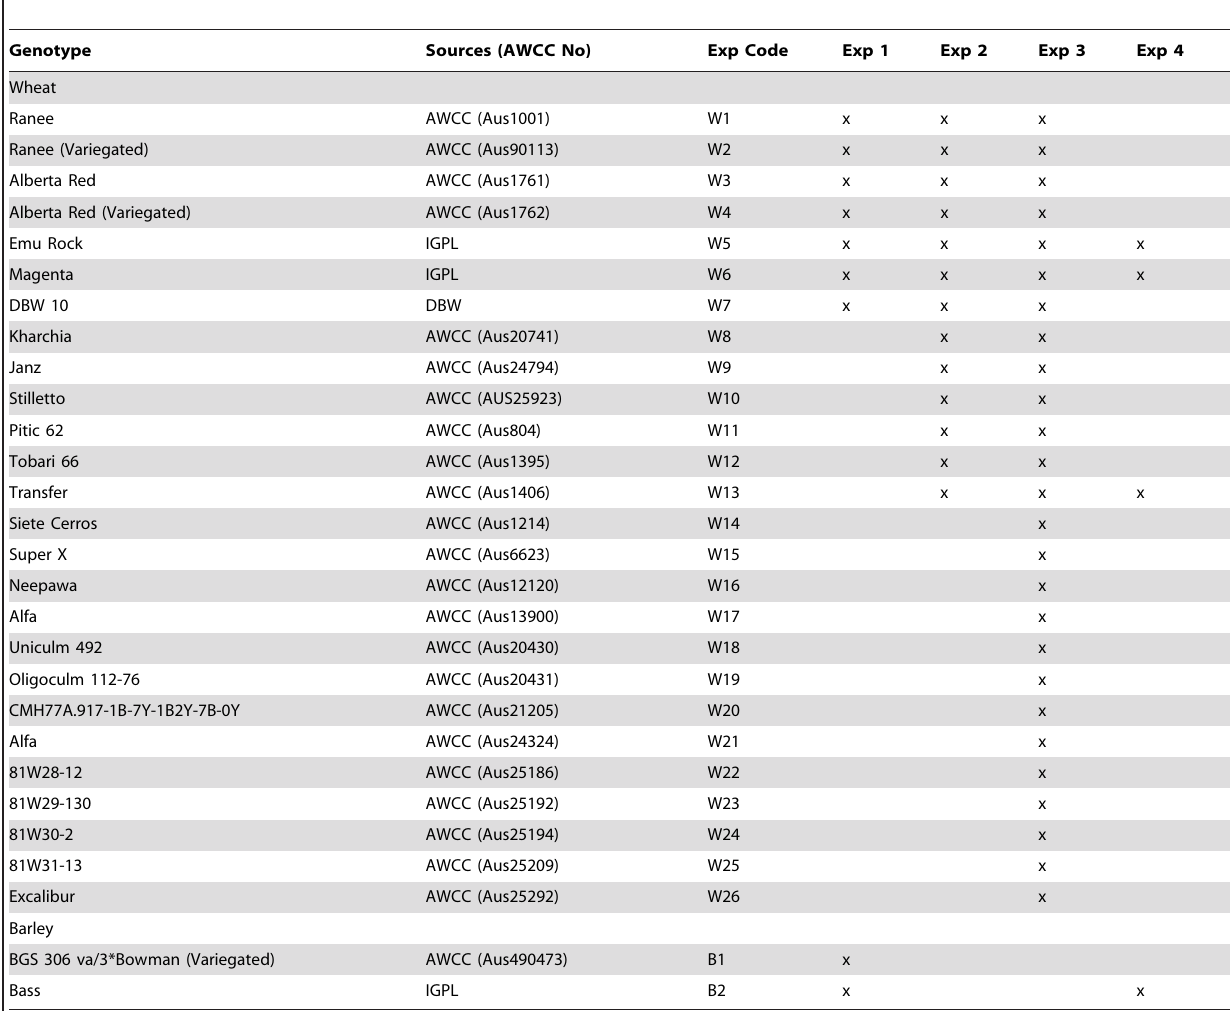
Table 1. List of the genotypes used in the four experiments and obtained from the Australian Winter Cereals Collection (AWCC), InterGrain Pty Ltd (IGPL) and Dr. D. Bowran